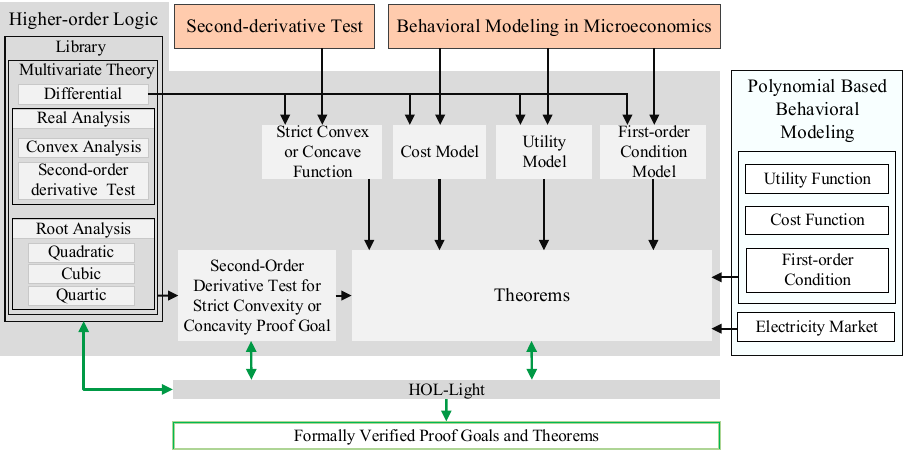
Figure 1. Proposed methodology for Microeconomics Models in